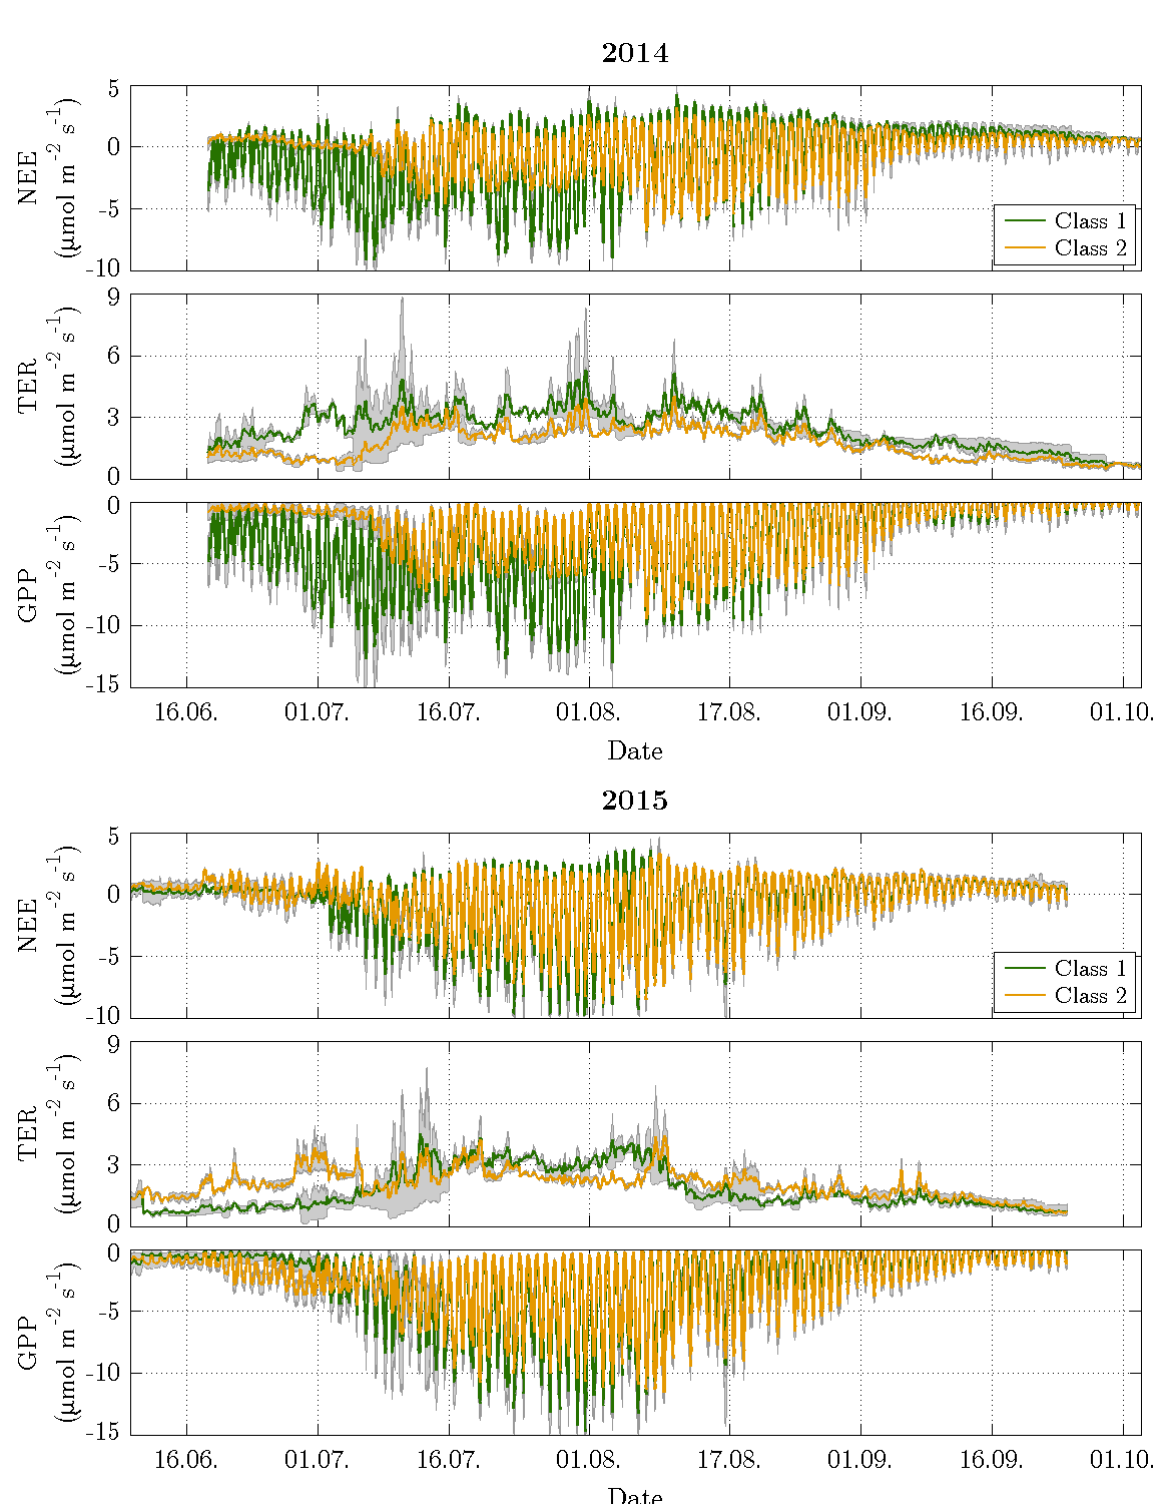
Figure 8. Time series of decomposed fluxes with 95% confidence intervals for both vegetation classes. The width of the confidence intervals varied depending on both the flux magnitude and the number of fitting parameters in the chosen model. The decomposition revealed a distinct difference in the net uptake between both vegetation classes during the first half of the growing season in 2014, while the flux dynamics of both vegetation classes were rather similar during the remaining time and in